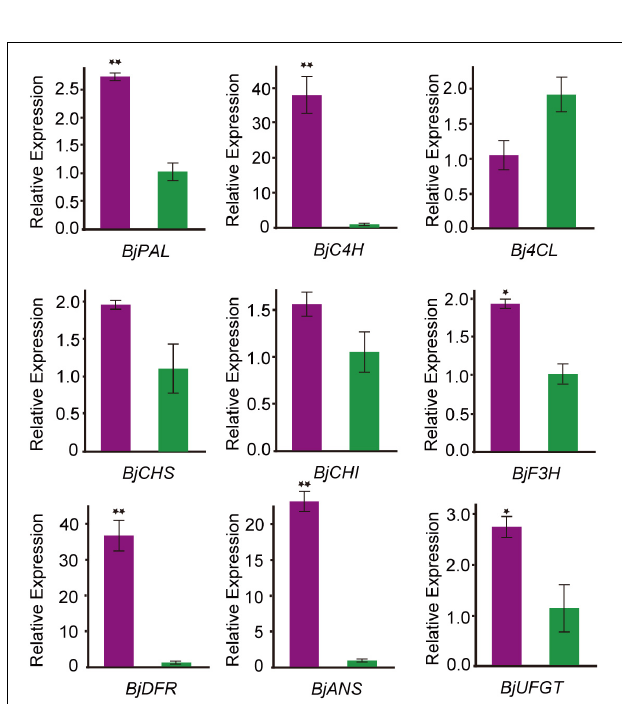
FIGURE 4 | Diagram and heatmaps of genes involved the anthocyanin biosynthesis pathway. (A) Schematic diagram of genes involved in the anthocyanin biosynthesis pathway. (B) Heatmaps of DEGs involved in the accumulation of anthocyanin in ZiYi B. juncea .